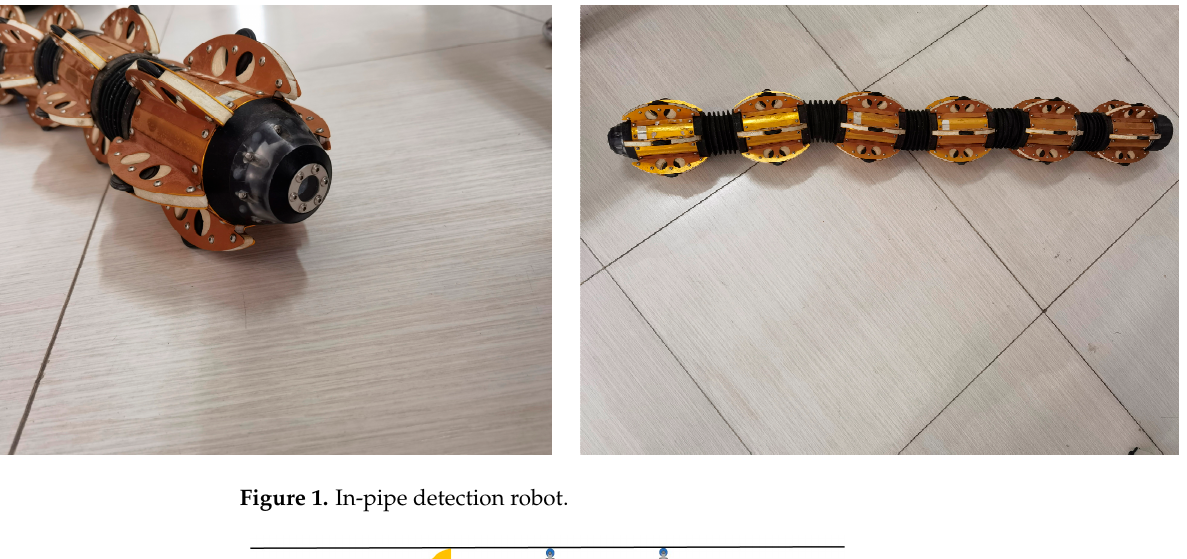
Figure 1. In-pipe detection robot.